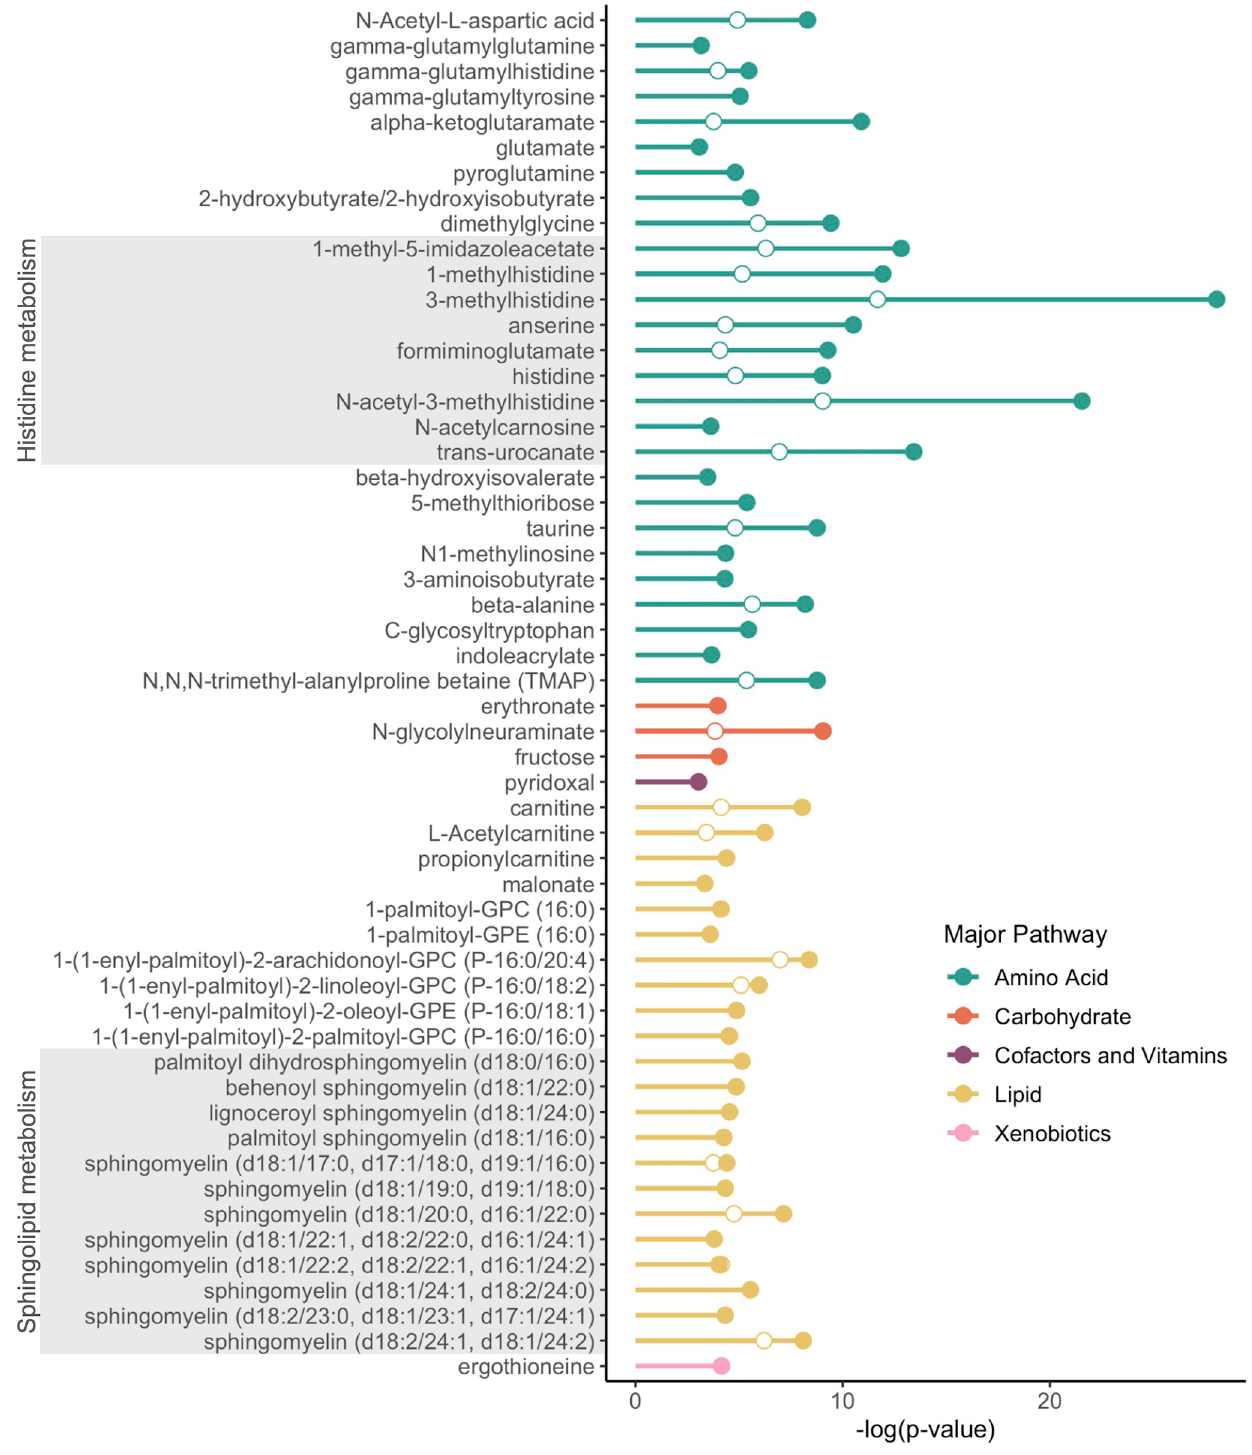
Fig 1. Metabolites associated with wooden breast and white striping. Top metabolites (q-value < 0.01) associated with wooden breast (closed circles) and white striping (open circles) in male broiler chickens at market age (7 weeks).